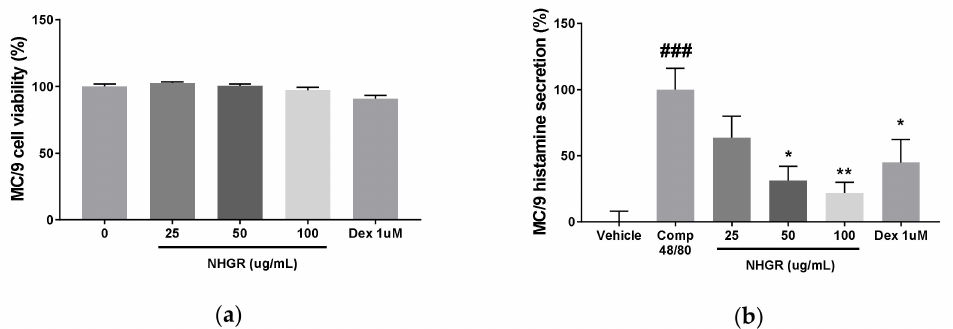
Figure 6. E ff ect of Siraitia grosvenorii residual extract (NHGR) on histamine secretion from MC / 9 mast cells. ( a ) Cell viability and ( b ) histamine secretion. MC / 9 cells (2 × 10 5 cells / mL) were treated with NHGR (25–100 µ g / mL) and compound 48 / 80 (25 µ g / mL) for 30 min. Data is showed as means ± SEM ( n = 3). ### p < 0.001 versus vehicle; * p < 0.05 and ** p < 0.01 versus compound 48 / 80-treated control.